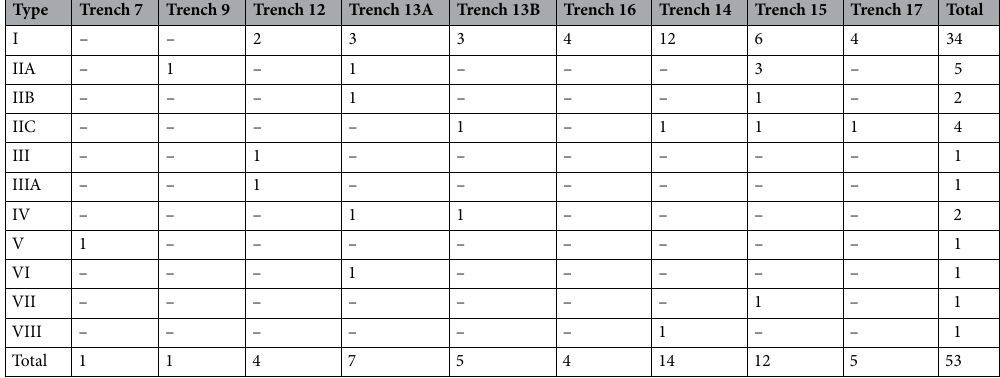
Table 1. Distribution of the different types of tombs by trench in the Campo de Hockey